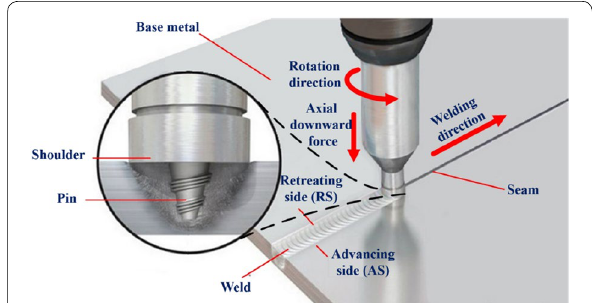
Figure 1 Schematic diagram of